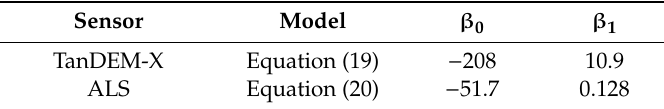
Table 1. The model parameter estimates.